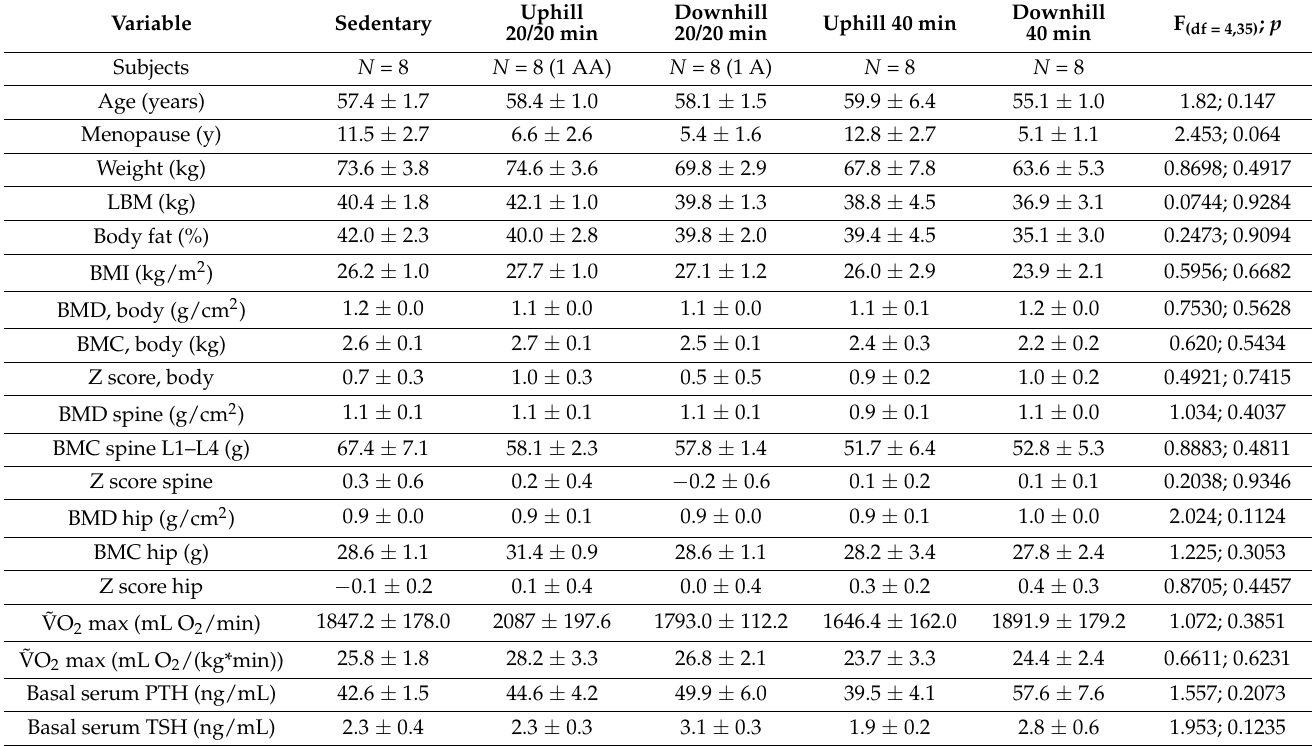
Table 2. Subject